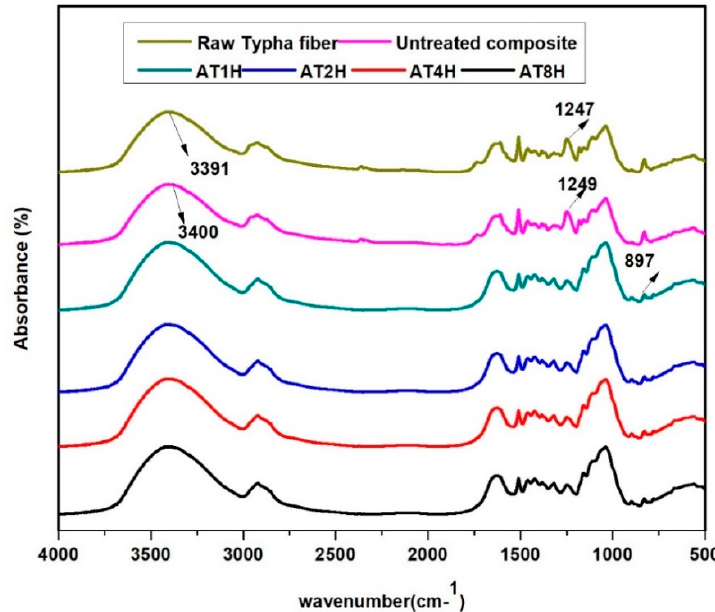
Figure 1. FTIR spectra of raw Typha fiber, untreated and treated Typha fiber reinforced epoxy composites.